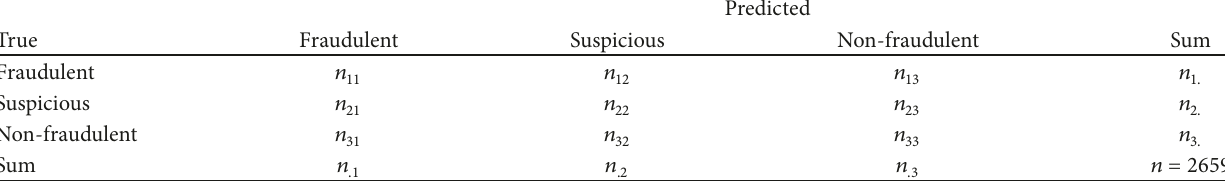
Table 3: A scheme of a confusion